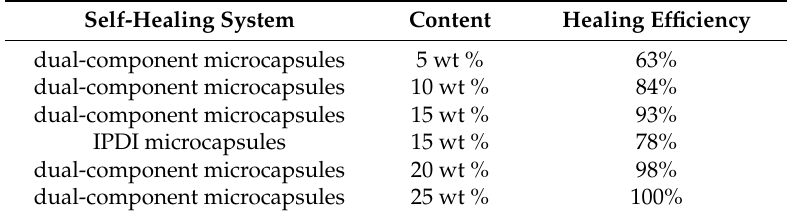
Table 3. Healing efficiency with different healing system and microcapsules